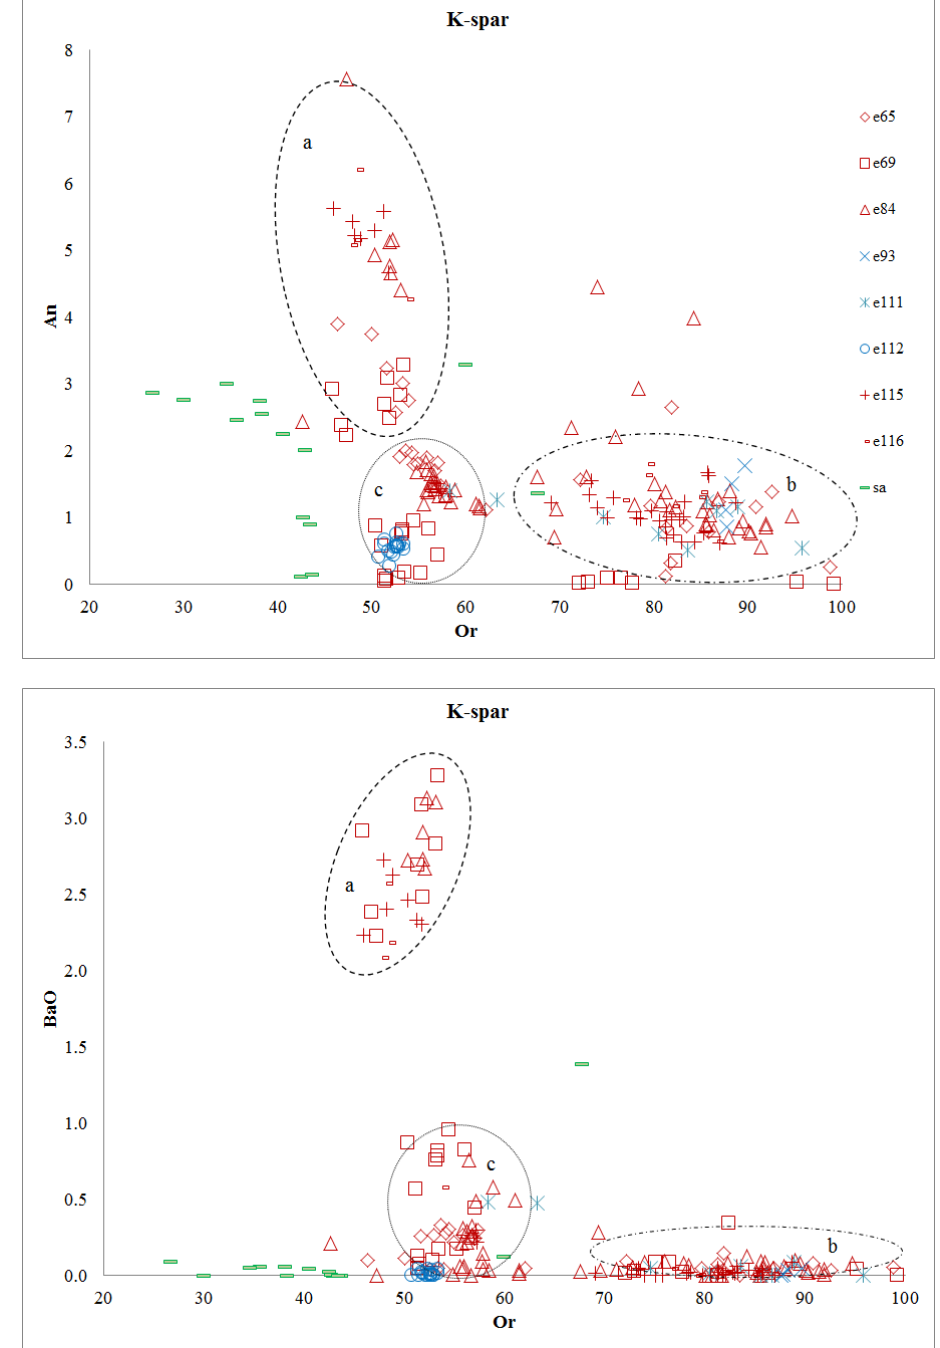
Figure 6. Feldspar chemical plots show the changes in mineral chemistry. There are different types of phenocrysts, (a) high BaO and high An group with Or around 50, (b) high K 2 O and low BaO group with Or larger than 70, and (c) a group with 0.5 wt.% BaO and An ranging from 1 – 2. The sanidines in the matrix fall in the region of the medium amount BaO (0.3 – 1 wt.%) with Or around 50 – 60. The sample sa3 has low Or and low BaO. The different types of phenocrysts indicate that they may come from different sources.